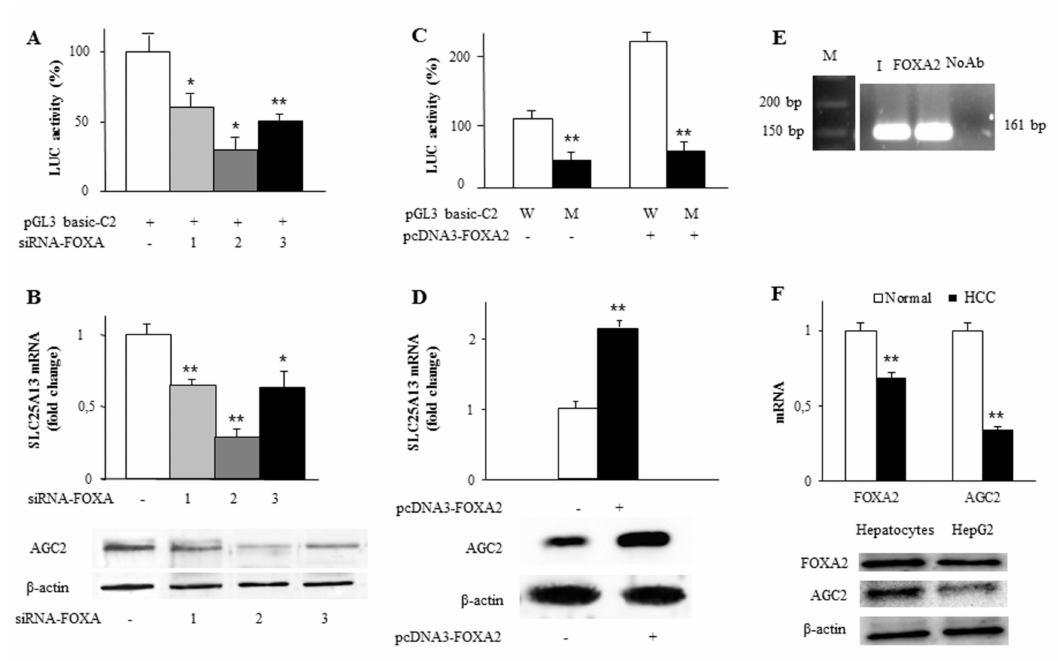
Figure 3. E ff ect of FOXA2 on SLC25A13 gene expression. ( A ) HepG2 cells co-transfected with pGL3 basic-LUC vector containing the − 968 / − 19 SLC25A13 gene promoter region and siRNA targeting human FOXA1, FOXA2 and FOXA3 or with control siRNA (-: white bar) were assayed for LUC activity. ( B ) Total RNA extracted from HepG2 cells transfected with siRNA targeting human FOXA1, FOXA2 and FOXA3 or with control siRNA (-: white bar) was used to quantify SLC25A13 mRNA by real-time PCR. AGC2 and β -actin proteins of transfected HepG2 cells were immunodecorated with specific antibodies. ( C ) HepG2 cells co-transfected with pGL3 basic-LUC vector containing the wild-type (W: white bar) or mutated (M: black bars) − 968 / − 19 SLC25A13 gene promoter region wild- type and with pcDNA3-FOXA2 ( + ) or empty pcDNA3 (-) were assayed for LUC activity. ( D ) Total RNA extracted from HepG2 cells transfected with pcDNA3-FOXA2 (black bar) or empty pcDNA3 (white bar) was used to quantify SLC25A13 mRNA by real-time PCR. AGC2 and β -actin of transfected HepG2 cells were immunodecorated with specific antibodies. ( E ) ChIP-qPCR assay of FOXA2 binding to the endogenous SLC25A13 gene promoter shows the − 1040 / − 864 bp region amplification band. M: Marker, lane I: Input, lane FOXA2: amplification PCR band after ChIP with a specific antibody for human FOXA2, lane NoAb: without the anti-FOXA2 antibody addition. ( F ) Total RNA extracted from normal (white bar) and hepatocellular carcinoma (HCC) (black bar) cells was used to quantify FOXA2 and SLC25A13 mRNAs by real-time PCR. FOXA2, AGC2 and β -actin proteins of primary hepatocytes and HepG2 cells were immunodecorated with specific antibodies. In ( A – D ) and ( F ) panels, means ± SD of three duplicate independent experiments are shown; all di ff erences between samples and relative controls were significant (* p < 0.05 or ** p < 0.01 one-way ANOVA followed by Student’s- t